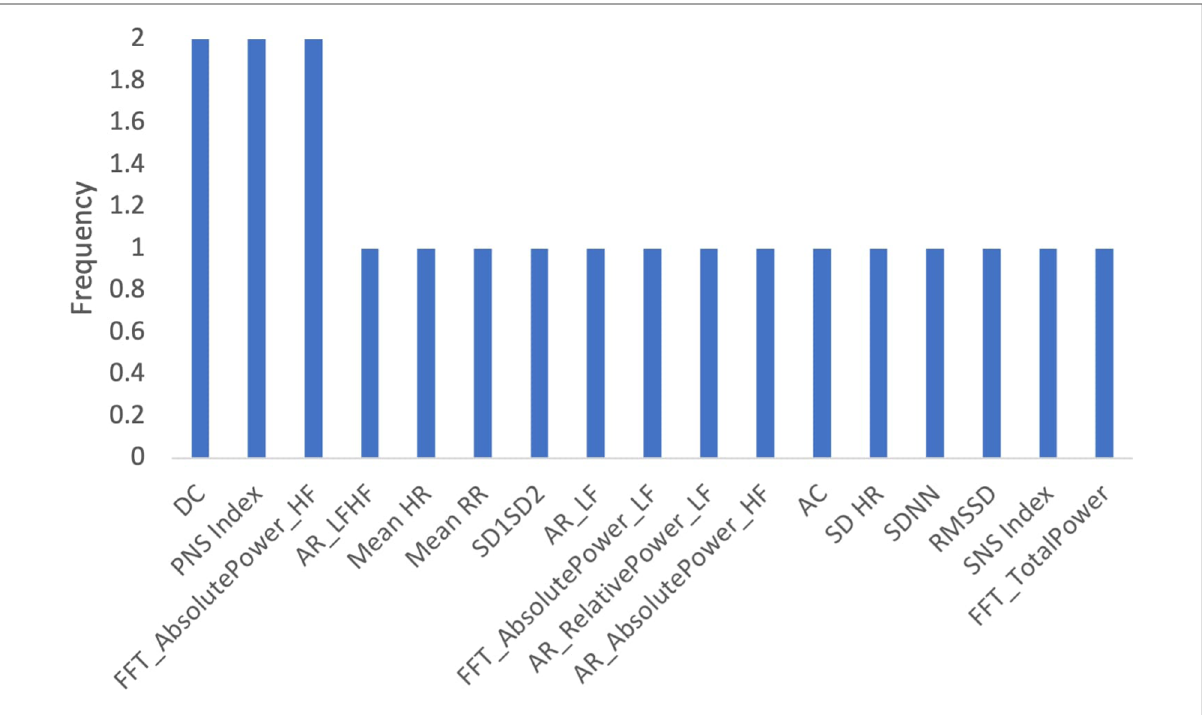
FIGURE 12 Frequency of Features in gender-related models.